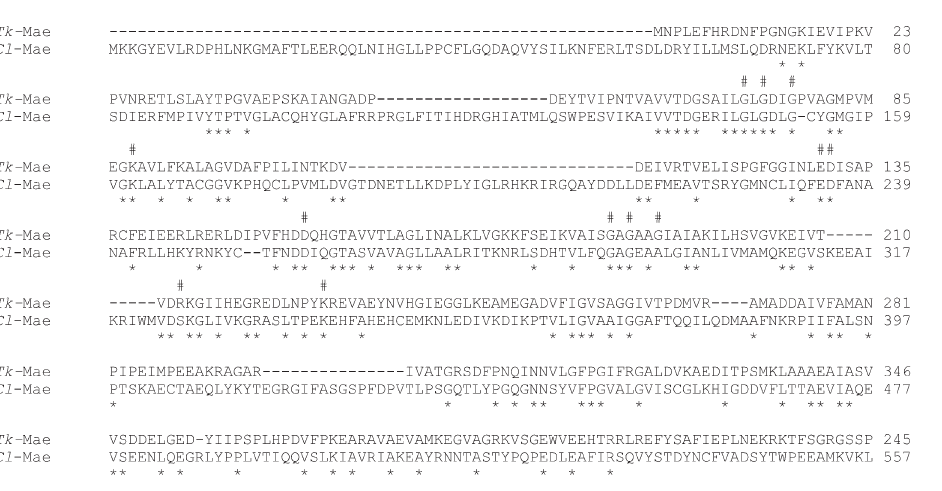
Figure 4. Purification and pH and temperature dependencies of recombinant T. kodakara- ensis malic enzyme ( Tk -Mae). (A) SDS-PAGE of purified re- combinant Tk -Mae. Lanes: 1 = soluble fraction after sonica- tion; 2 = soluble fraction after heat treatment at 80 °C for 20 min; 3 = after anion ex- change chromatography with Resource Q; and 4 = after gel filtration chromatography with Superdex 200 10/30HR. (B) Effect of pH on enzyme activ-